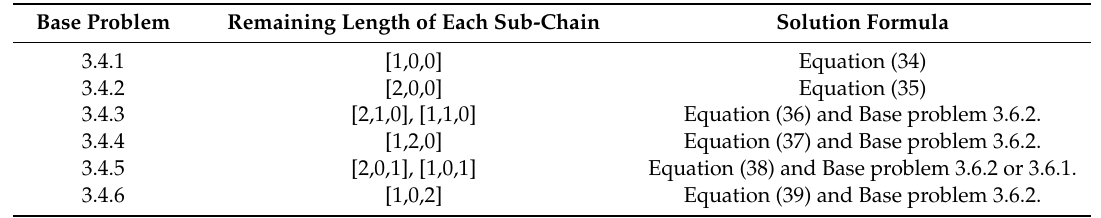
Table 6. The six basic problems in the third